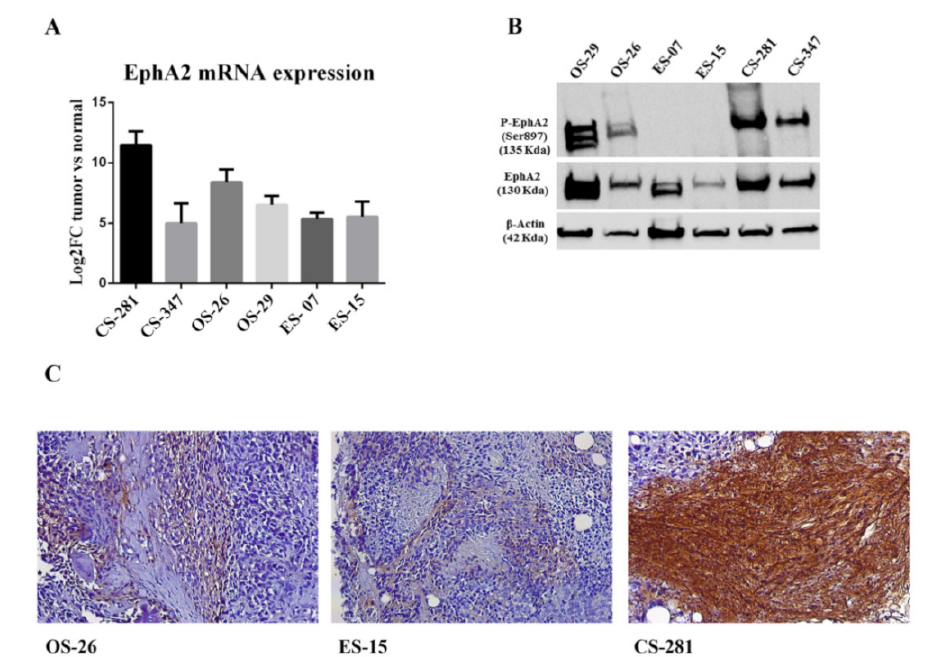
Figure 6. EphA2 expression in human bone sarcomas and patient-derived xenografts. ( A ) EphA2 mRNA expression in primary human tumors compared to normal counterparts, as obtained by quantitative real time PCR. ( B ) Western blot analysis of phosphorylated-EphA2 (Ser897), EphA2 and β -actin (housekeeping protein as loading control) as obtained from PDX protein extracts. Osteosarcoma (OS-26, OS-29); Ewing Sarcoma (ES-07,ES-15); Chondrosarcoma (CS-281, CS-347). ( C ) Immunohistochemistry showing EphA2 staining in PDXs.